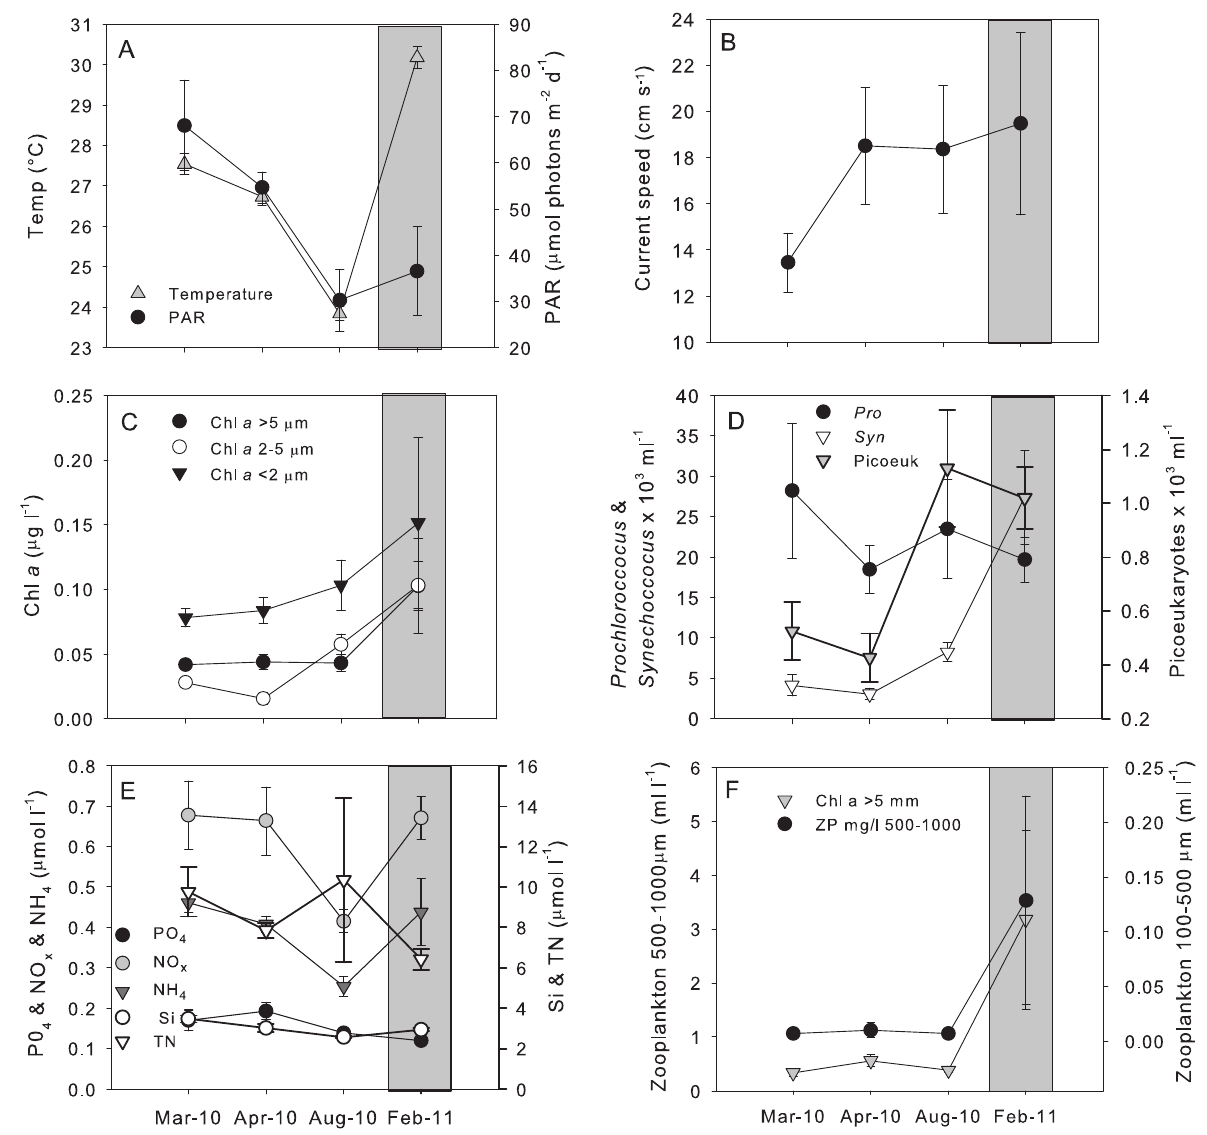
Figure 3. Patterns in physico-chemical factors at Ningaloo Reef throughout seasons. (A) Temperature ( u C) and light (PAR), (B) current speed, (C) chlorophyll a (chl a ), (D) picoplankton concentration ( Prochloroccocus , Synechoccocus and picoeukaryotes ), (E) nutrients (PO 4 , NO 3 + NO 2 (NO x ), NH 4 , Si and TN) and (F) zooplankton concentrations at six stations at Ningaloo Reef during autumn (March/April) and winter (August 2010) and during the La Nin˜a event in summer (February 2011) (grey column). Data are means 6 SE